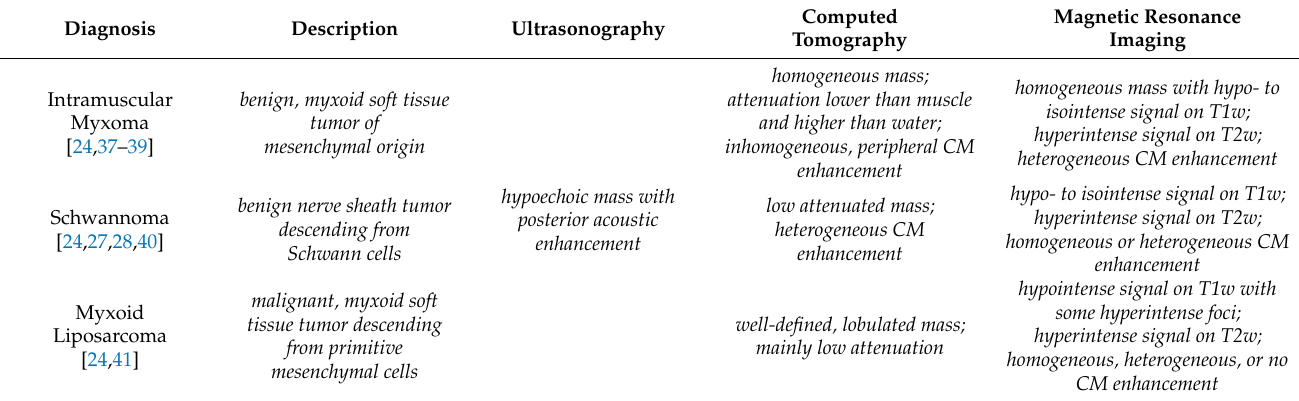
Table 1. Radiological characteristics of IMMs and its most common differential